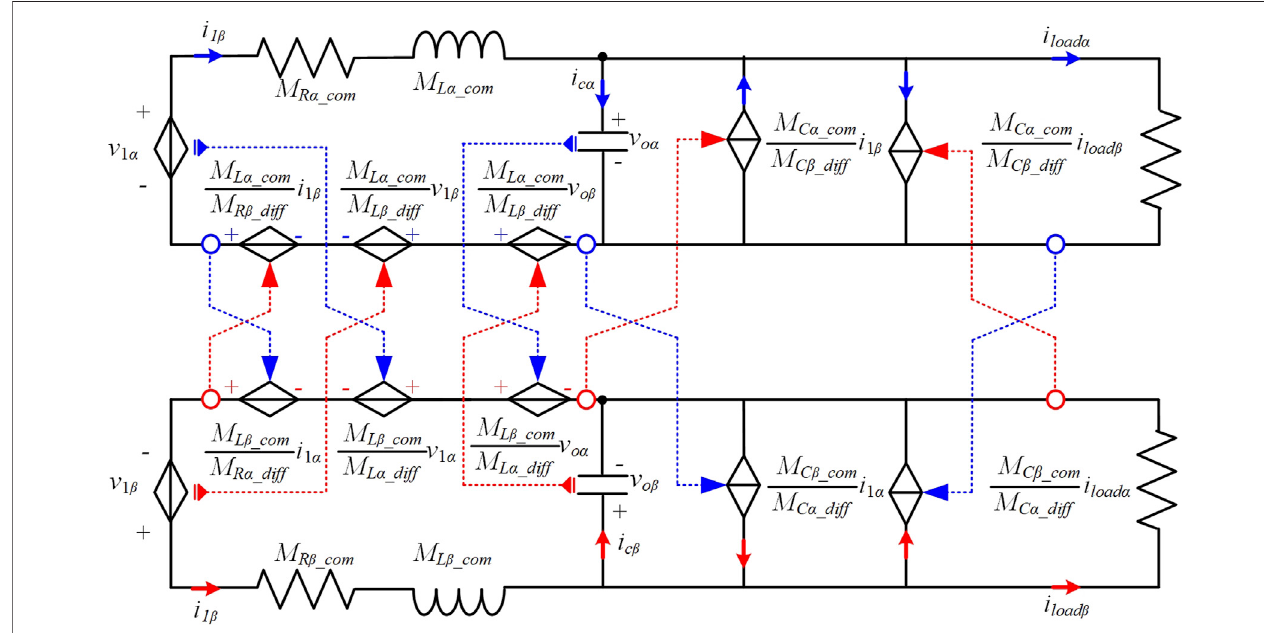
FIGURE 3 | Equivalent circuit of a DES module in αβ stationary reference